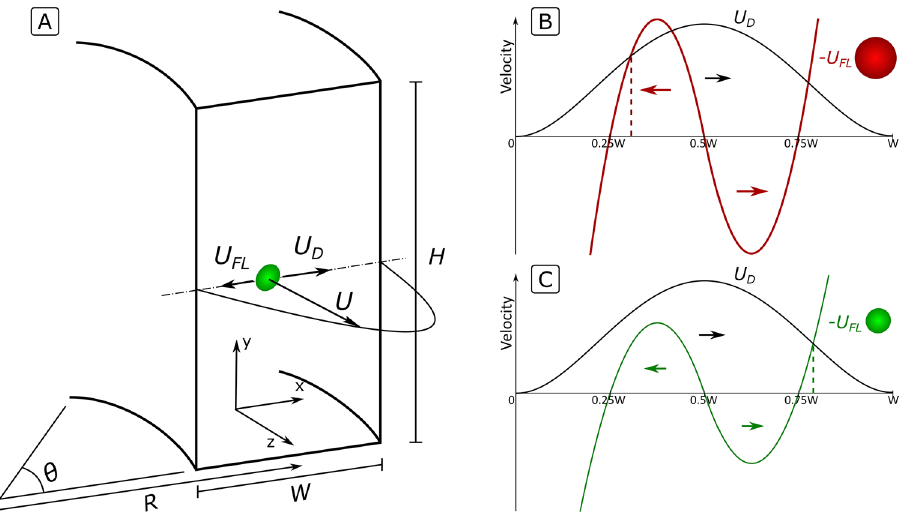
Figure 2. ( A ) Variables in a HARC system ( B , C ) Magnitude and direction of U D and U FL at the symmetry line for ( B ) a situation where U FL dominates; U D does not surpass the Lift Barrier and the particle remains at the inner wall ( C ) a situation where U D dominates; it surpasses the Lift Barrier and the particle travels towards the outer wall. The dashed lines indicate the focus position (provided the initial position is 0.25 W